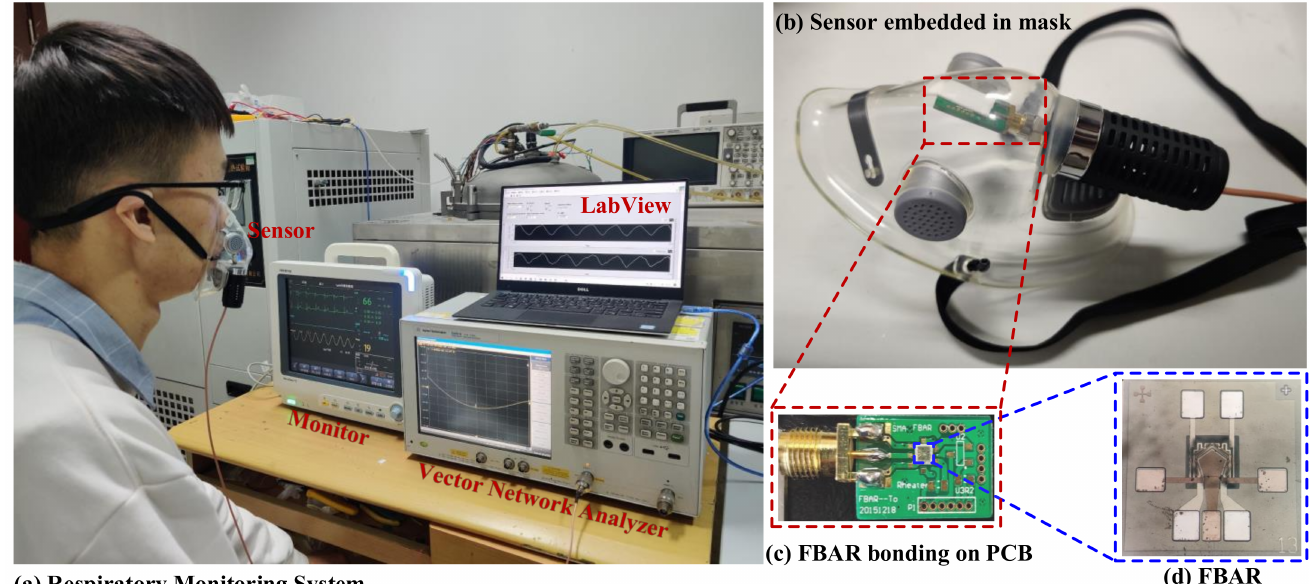
Figure 5. ( a ) Respiration monitoring system; ( b ) PI-FBAR humidity sensor embedded in breathing mask; ( c ) PI-FBAR bonding on PCB; ( d ) image of